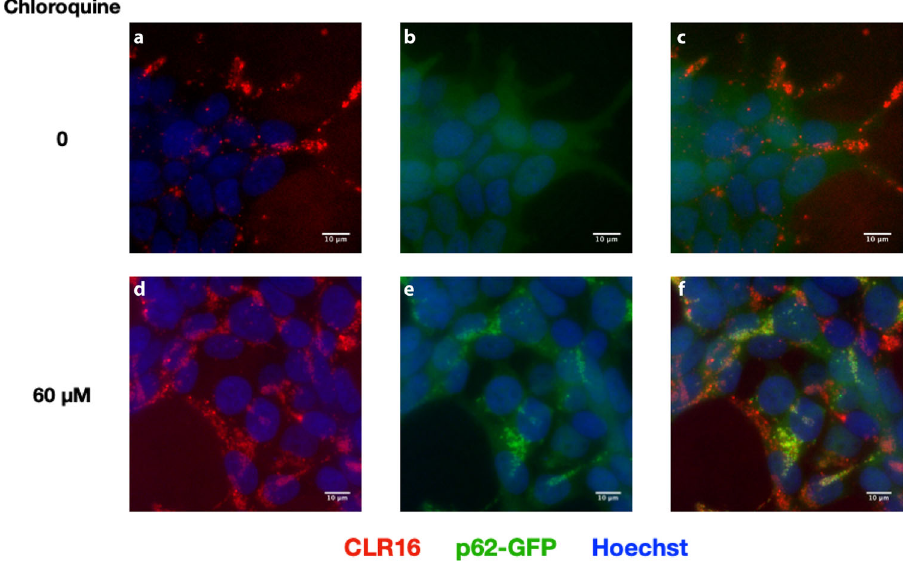
Fig. 7 CLR16 colocalizes with autophagosomes. SH-SY5Y cells were transfected with GFP-p62, incubated with 5 µ M CLR16 in the absence ( a – c ) or presence ( d – f ) of chloroquine for 24 h, and stained with Hoechst.